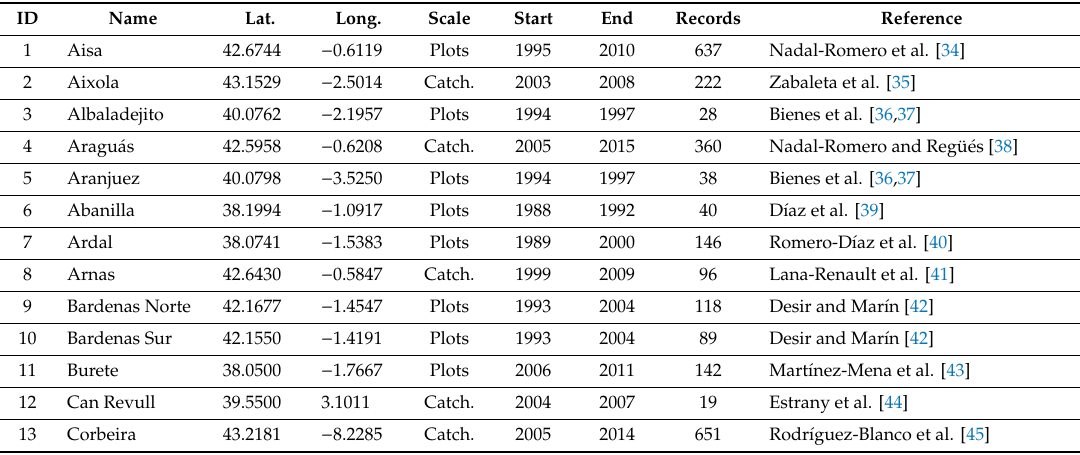
Table 1. Location of study sites (catchments and plots), data collection period (start and end), number of records, and reference of the study sites included in the